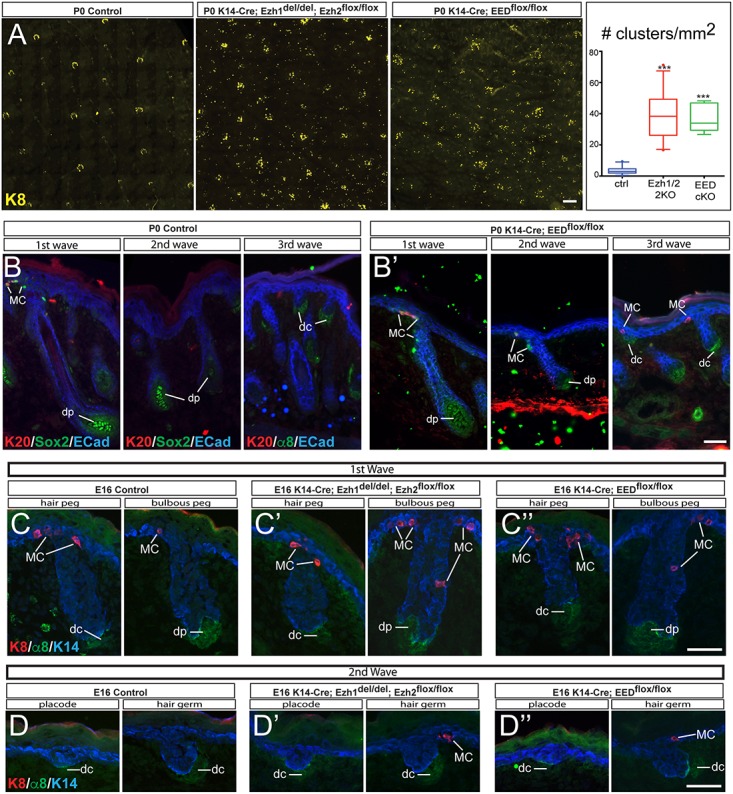
Loss of PRC2 results in ectopic formation of Merkel cells around all hair follicle types.(A) Whole-mount immunofluorescence staining showing Merkel cell-specific marker Krt8 (K8) in P0 Ezh1/2 2KO (K14-Cre; Ezh1del/del;Ezh2flox/flox) and EED cKO (K14-Cre; EEDflox/flox) epidermis compared to control (ctrl). Clusters of Merkel cells (≥3 Krt8(+) cells) are quantified, and the number of clusters of Merkel cells per mm2 is presented to the right (Kruskal-Wallis test p<0.0001; ctrl vs. Ezh1/2 2KO, *** p<0.0001; ctrl vs. EED cKO, *** p<0.0001). (B-B’) All hair types can have adjacent Merkel cells in EED cKO (B’), while only first wave hair follicles have adjacent Merkel cells in WT (B) epidermis. IF stainings for Sox2 and integrin α8 (α8) are used to label the dermal papillae (dp) or dermal condensate (dc) of different hair follicle types. The dermal papillae of first (left) and second (middle) wave hair follicles are Sox2(+), and the two types of hair follicles can be discriminated by size. The dermal papillae of the third (right) wave hair follicles are Sox2(-)/α8(+), and these hair follicles are very short at P0. IF staining for Sox2 identifies early-specified Merkel Cells (MC) and Krt20 (K20) identifies mature Merkel cells in the epidermis, which is labeled with E-Cadherin (ECad). (C-D”) Early immature Krt8(+) Merkel cells are found around the WT first wave (C) of developing hair follicles, but not the second wave (D) (control: 0% of placodes, 0.81% of hair germs, 19.65% of hair pegs, and 63.89% of bulbous pegs harbor Merkel cells around them; 148 hair follicles analyzed). (C’,C”,D’,D”) Krt8(+) Merkel cells are found around second wave and first wave developing hair follicles in Ezh1/2 2KO (C’,D’) and EED cKO (C”,D”) E16 embryos (Ezh1/2 2KO: 11.26% of placodes, 23.64% of hair germs, 58.33% of hair pegs, and 100% of bulbous pegs harbor Merkel cells around them; 160 hair follicles analyzed. EED cKO: 12.04% of placodes, 25.76% of hair germs, 70.37% of hair pegs, and 100% of bulbous pegs harbor Merkel cells around them; 213 hair follicles analyzed). Krt14 (K14) labels the developing hair follicles, and integrin α8 labels the dermal condensate in the first stages of hair follicle development; this becomes the dermal papilla in the bulbous peg stage. At E16, the first wave hair follicles are in the hair peg or bulbous peg stages (C-C”), while the second wave hair follicles are in the placode and hair germ stages (D-D”). Scale bars (A): 200 μm; (B-D”) 25 μm.